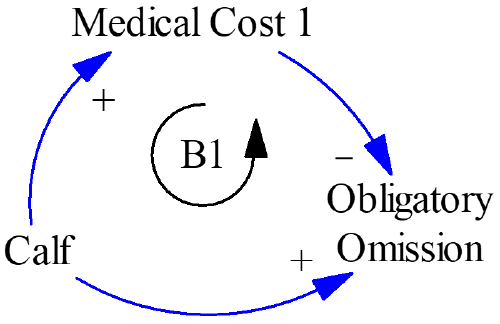
Figure 3. Control, protection, and development loop of the calf.